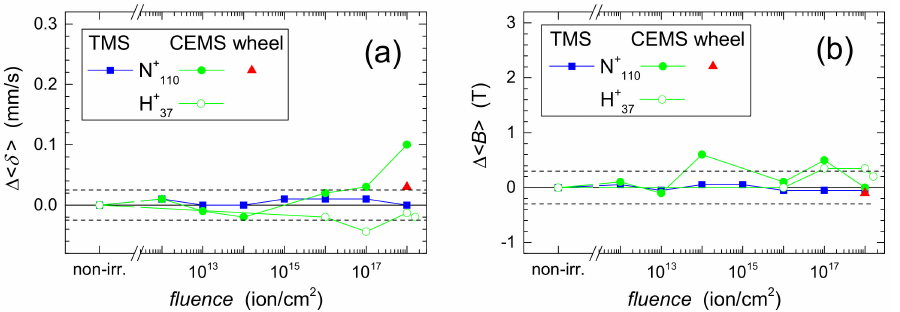
Figure 8. Differences of parameters derived from transmission (TMS, blue) and CEMS (green) Mössbauer spectra of irradiated and non-irradiated Fe 74 Cu 1 Nb 3 Si 16 B 6 amorphous metallic alloy exposed to 37 keV H + and 110 keV N + ions as plotted against the ion fluence: ( a ) average isomer shift, ∆ (cid:104) δ (cid:105) ; ( b ) average hyperfine magnetic field, ∆ (cid:104) B (cid:105) . Red triangles correspond to CEMS spectra taken from the wheel side of the ribbons. Solid lines are only guides for the eye, dashed lines represent the error margins.